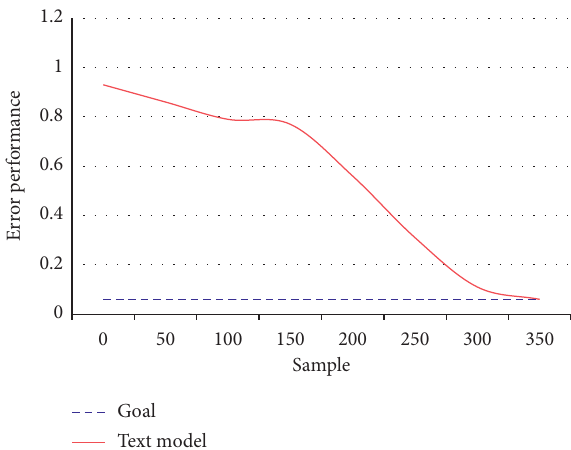
Figure 6: Error performance curve of traditional model.